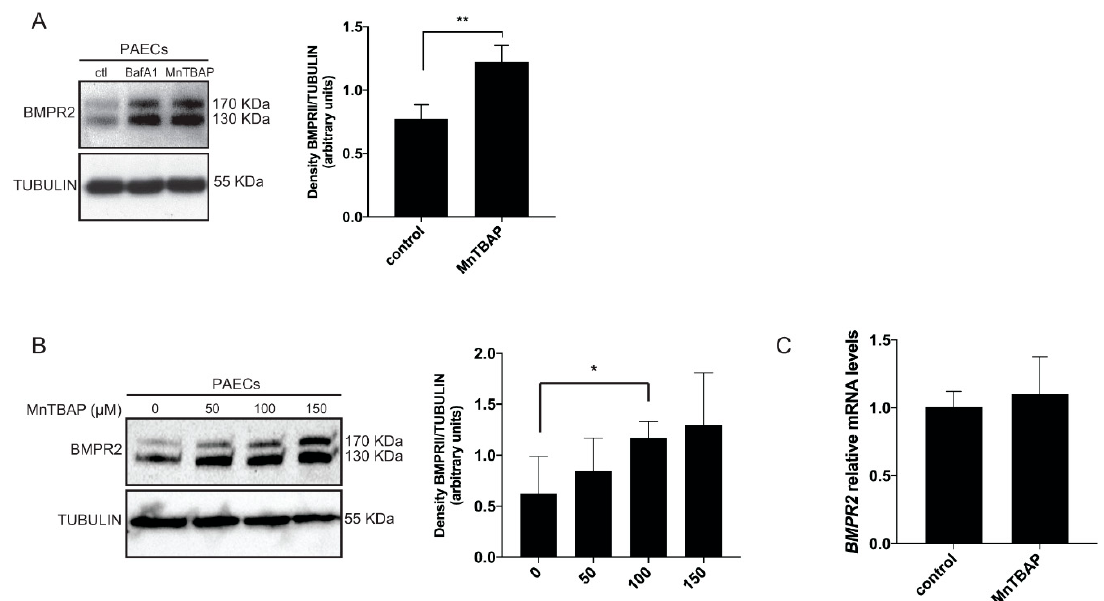
Figure 1. MnTBAP increases BMPR2 at the post-transcriptional level. ( A ) pulmonary artery endothelial cells (PAECs) were treated with MnTBAP (50 µM) and BafA1 (20 nM) for 16 h. Left panel: BMPR2 protein expression was analyzed by western blot. BMPR2 protein levels increased after treatment. Tubulin is used as a loading control. Representative results of at least 3 independent experiments are shown. Right panel: Quantification of BMPR2 protein levels normalized for tubulin. ( B ) PAECs were treated with 50 µM, 100 µM and 150 µM of MnTBAP for 16 h. BMPR2 levels increased in a dose dependent manner. ( C ) BMPR2 mRNA expression analyzed by qRT-PCR remains constant after PAECs were treated with MnTBAP (50 µM). Data presented as mean ± SD. * p < 0.05, ** p < 0.01.